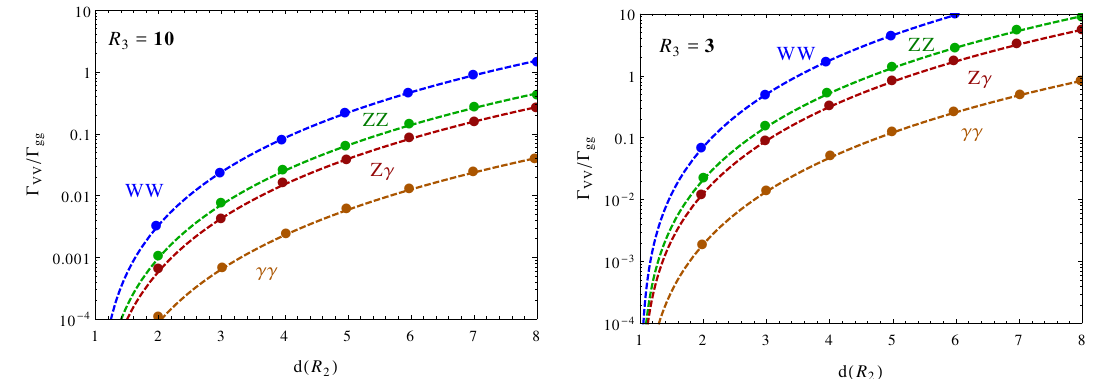
Figure 22 . The ratios (cid:0) WW = (cid:0) gg (blue), (cid:0) ZZ = (cid:0) gg (green), (cid:0) Z(cid:13) = (cid:0) gg (red), and (cid:0) (cid:13)(cid:13) = (cid:0) gg (orange) versus d ( R 2 ) for R 3 = 10 (left) and R 3 = 3 (right) for low M S (see main text). above the matching scale, at high M S , where the gauge couplings experience BSM